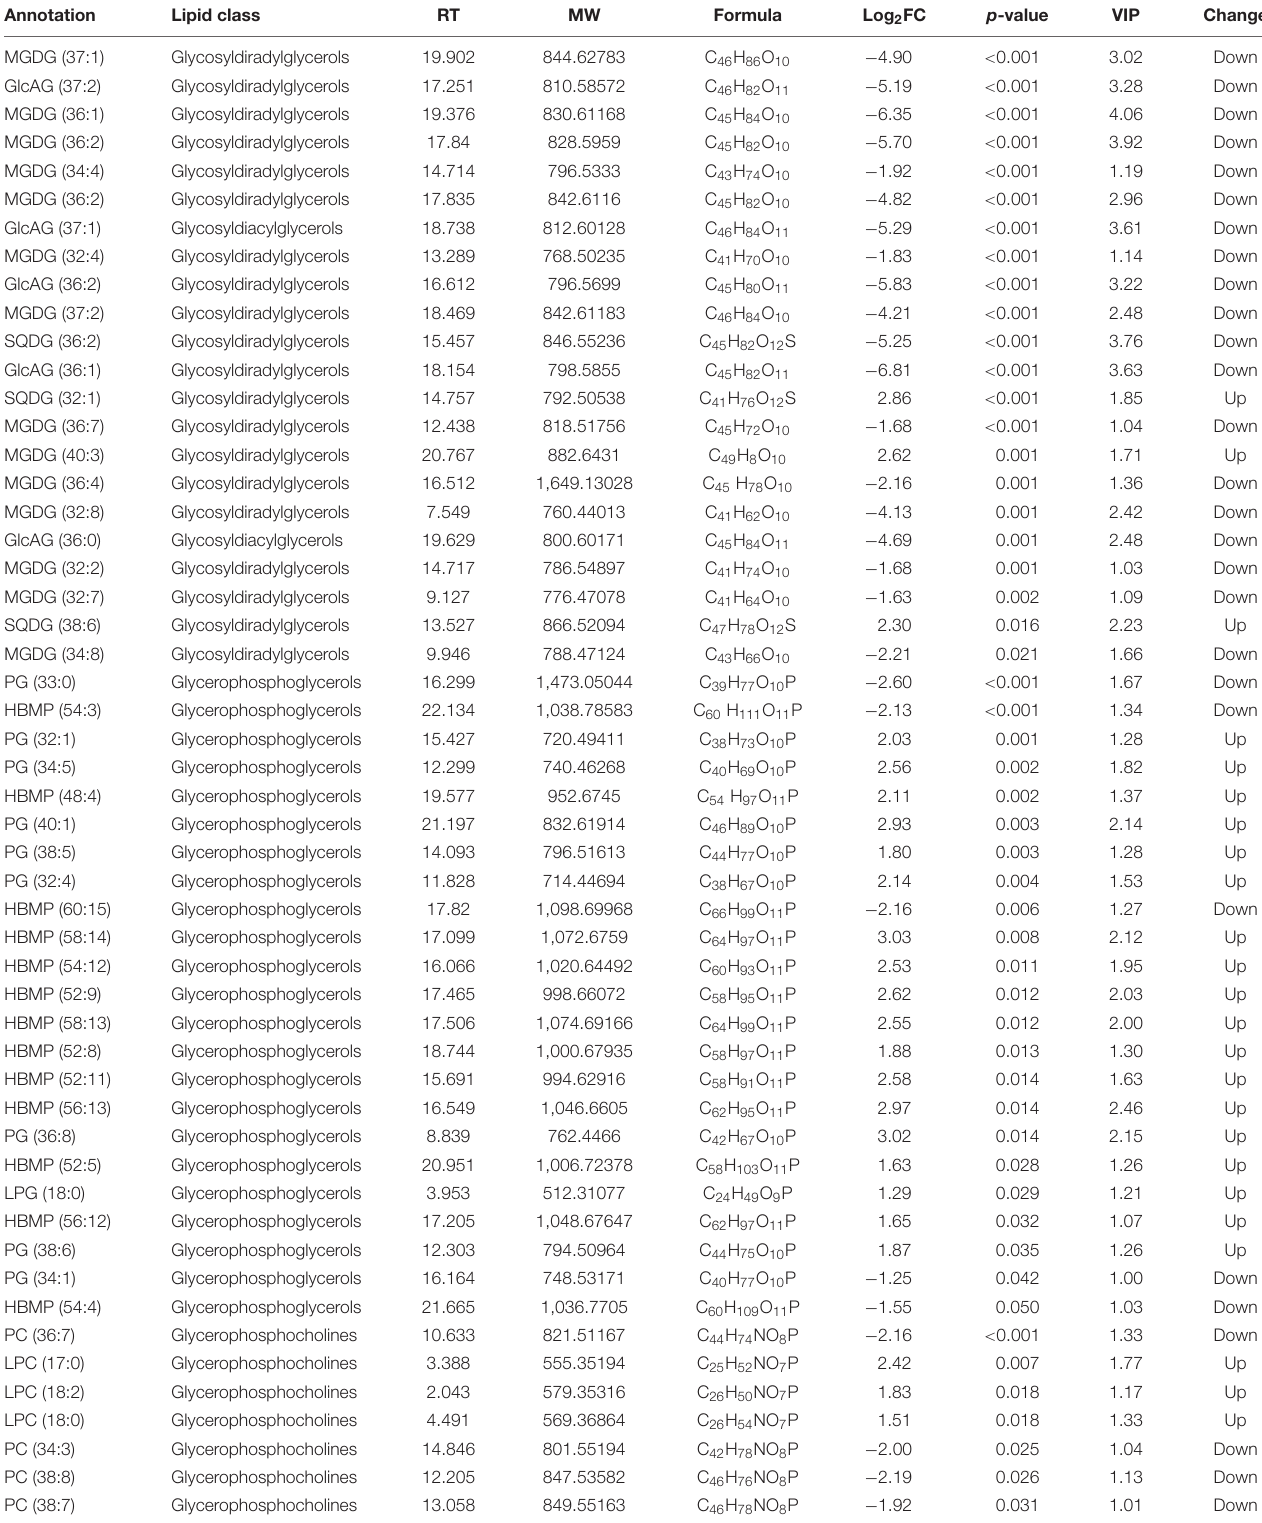
TABLE 1 | Lipid metabolites that showed greater than twofold alterations in abundance in Phaeodactylum tricornutum selected under low (400 µ am, ambient CO 2 condition) or high CO 2 (1,000 µ am, projected year 2100 high CO 2 according to high emission scenario RCP 8.5) for nearly 400